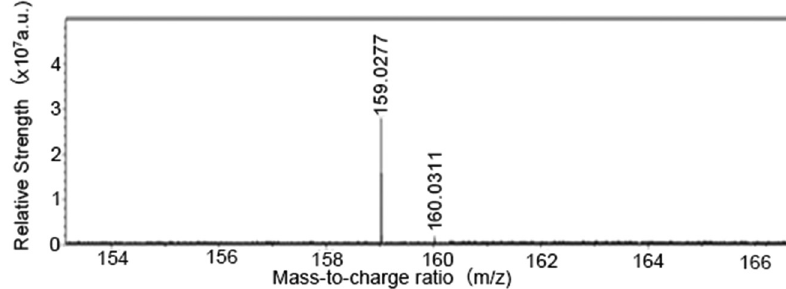
Figure 2: The mass spectrum of hypoxanthine with ethanol as the